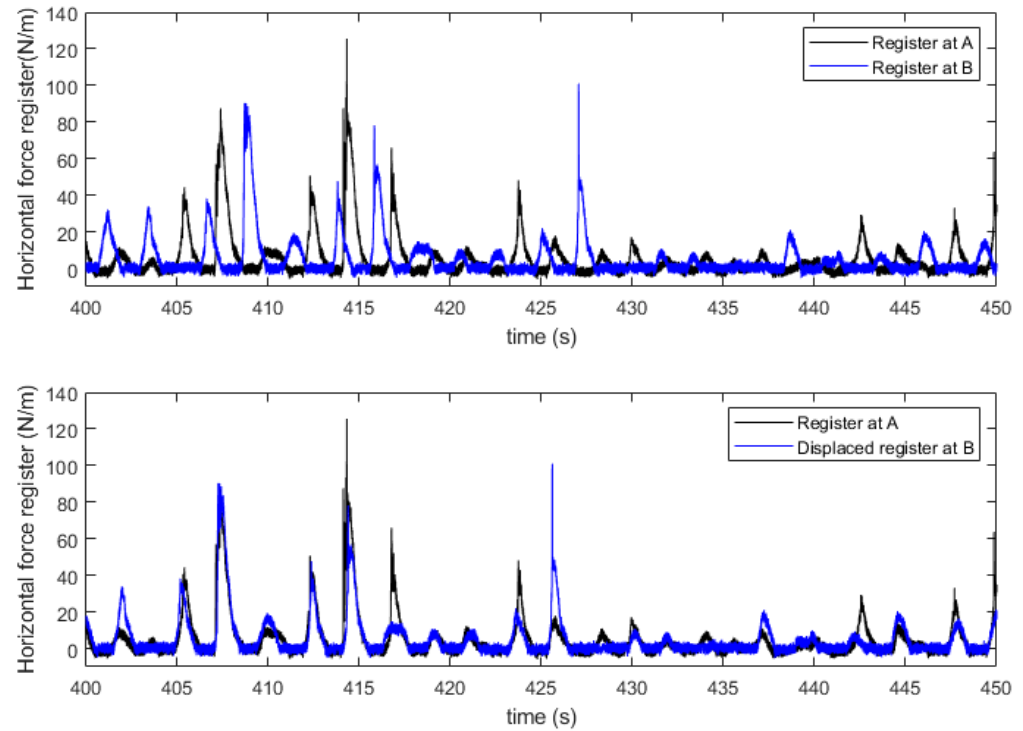
Figure 15. Example of applying the maximum correlation travel time to displace the register at measurement point B (Test #5).